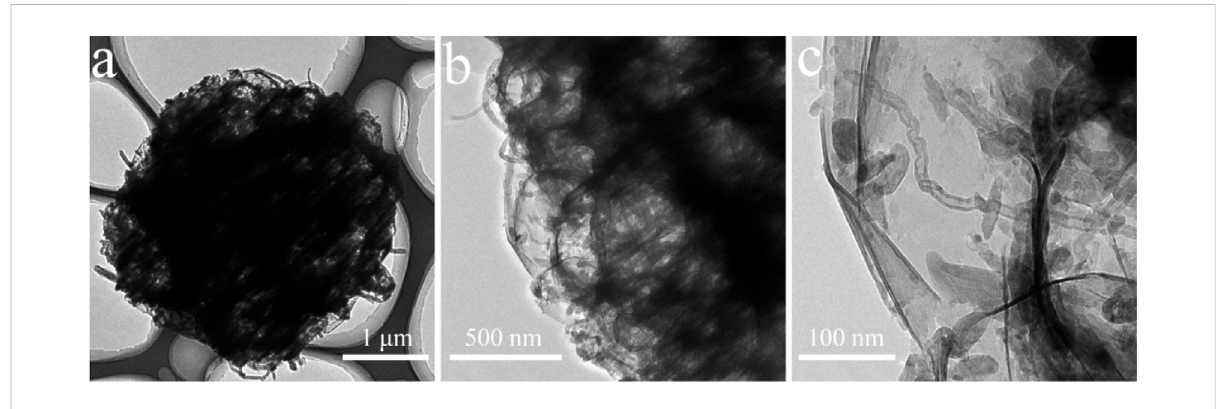
FIGURE 2 TEM images (A – C) of 3D CNT/MXene